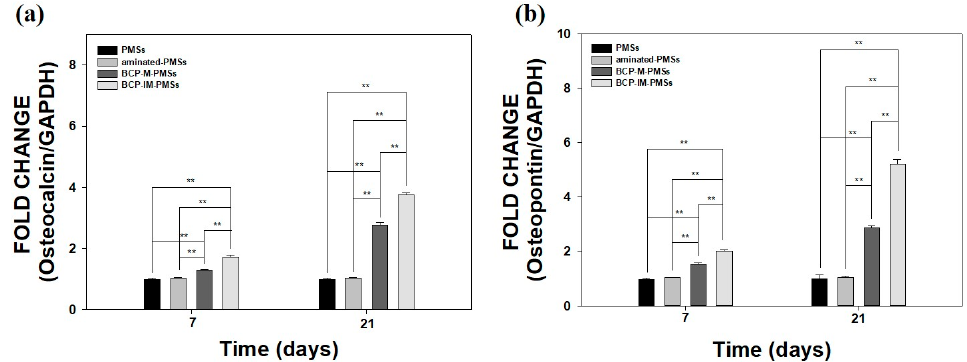
Figure 6. Real-time PCR analysis of ( a ) osteocalcin (OCN) and ( b ) osteopontin (OPN) expression in MG-63 cells after 7 or 21 days of incubation with PMSs, aminated-PMSs, BCP-M-PMSs, or BCP-IM- PMSs ( n = 5) (* p < 0.05 and ** p < 0.01).